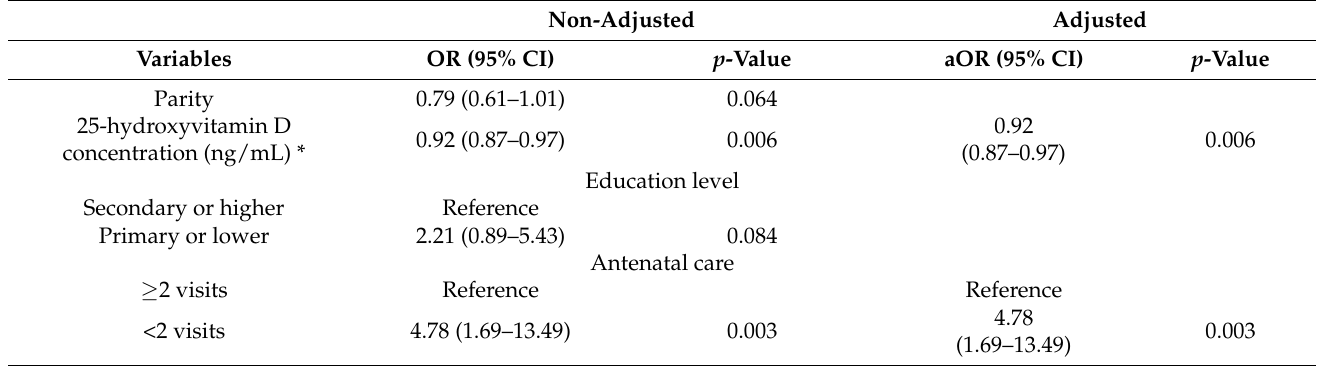
Table 2. Multivariable analysis of the non-adjusted and adjusted odds ratio of the factors associated with preterm birth (cases) compared with the controls.